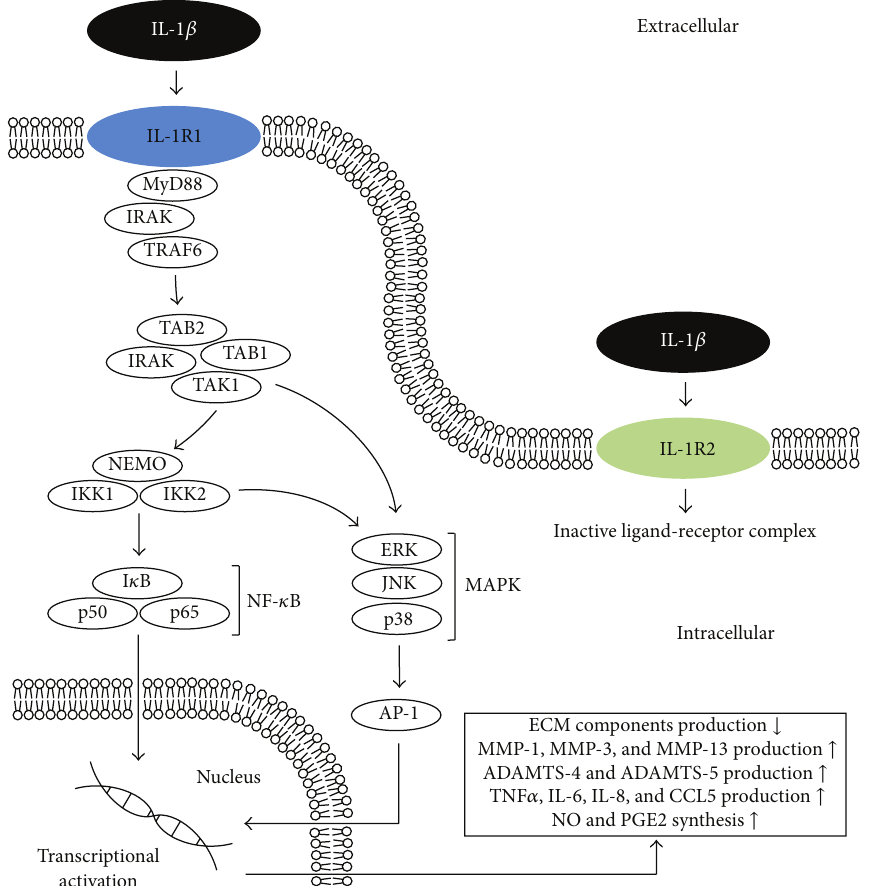
Figure 2: IL-1 𝛽 associated intracellular signaling pathways and downstream cellular targets and effects. IL-1R1: interleukin-1 receptor, type 1; IL-1R2: interleukin-1 receptor, type 2; MyD88: myeloid differentiation primary response gene (88); IRAK: interleukin-1 receptor-associated kinase; TRAF6: TNF receptor-associated factor 6; TAK1: also known as mitogen-activated protein kinase kinase kinase 7 (MAP3K7); TAB1: also known as mitogen-activated protein kinase kinase kinase 7 interacting protein 1 (MAP3K7IP1); TAB2: also known as mitogen-activated protein kinase kinase kinase 7 interacting protein 2 (MAP3K7IP2); p50, p65: subunits of proteins forming NF- 𝜅 B; I 𝜅 B: (inhibitor of 𝜅 B) an endogenous complex of proteins inhibiting the activation of NF- 𝜅 B; IKK1,2/NEMO: NF- 𝜅 B inhibitor kinase 1,2 (I 𝜅 B kinase 1,2)/NF- 𝜅 B kinase inhibitor (NF- 𝜅 B essential modulator); ERK: extracellular-signal-regulated kinase; JNK: c-Jun N-terminal kinase; p38: p38 mitogen-activated protein kinases; MAPK: mitogen-activated protein kinases; AP-1: activator protein